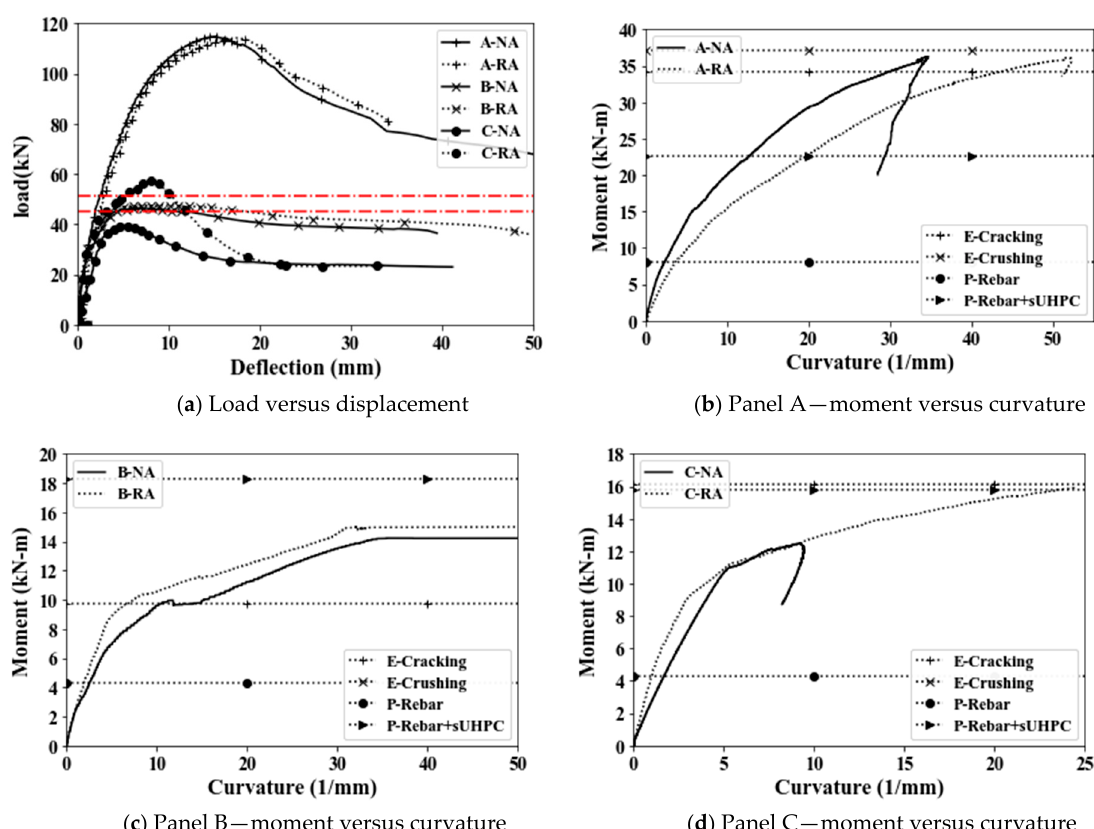
Figure 9. Load deflection responses of composite deck panels.